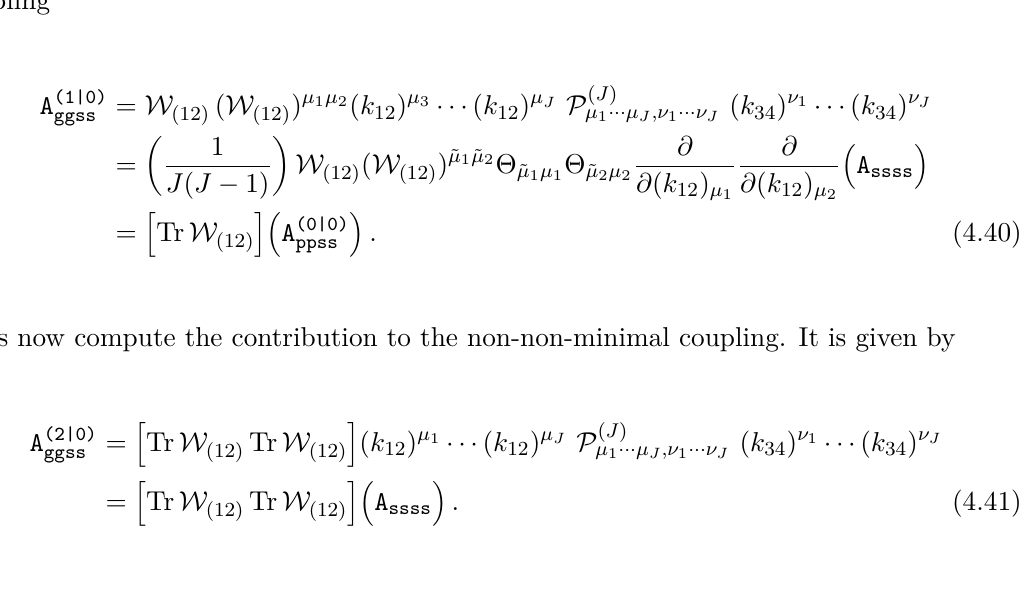
Amplitudes due to the non-minimal